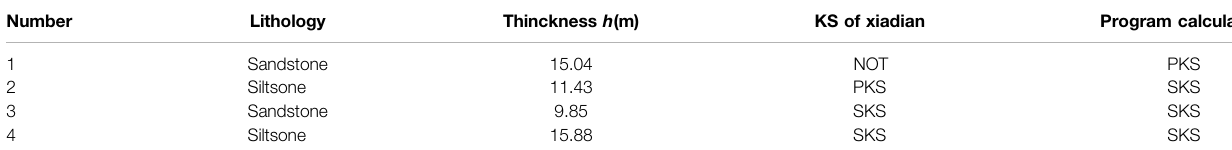
Table 2 | Comparisons of program calculation and actual practical example.